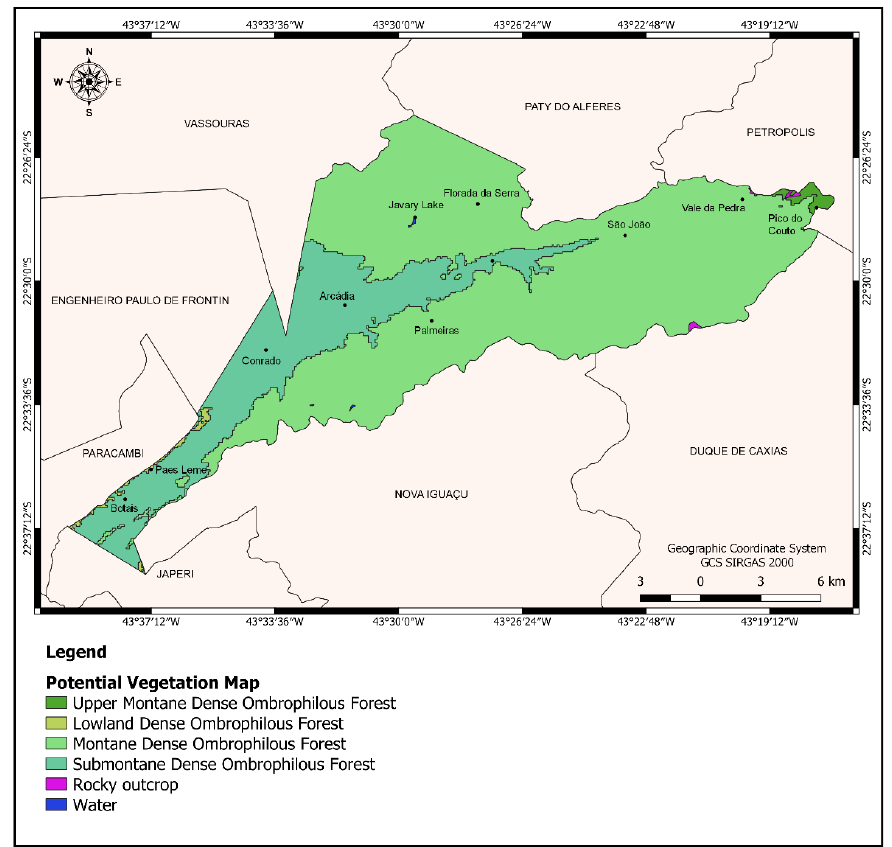
Figure 4. Potential vegetation map of Miguel Pereira municipality, Rio de Janeiro State, Brazil [54].